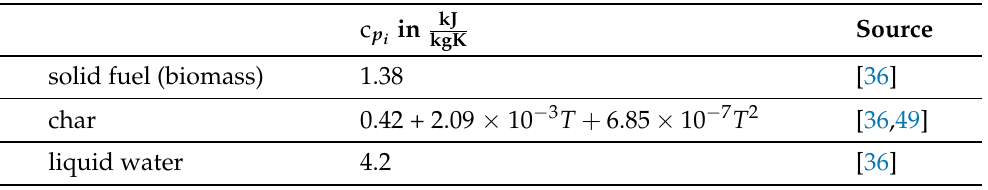
Table 3. The specific mean heat capacity of the solid-phase